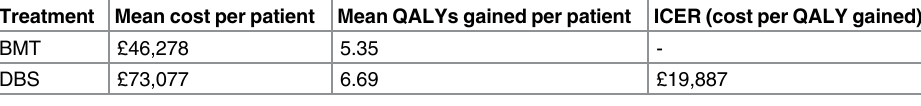
Table 1. Deterministic model results (discounted).